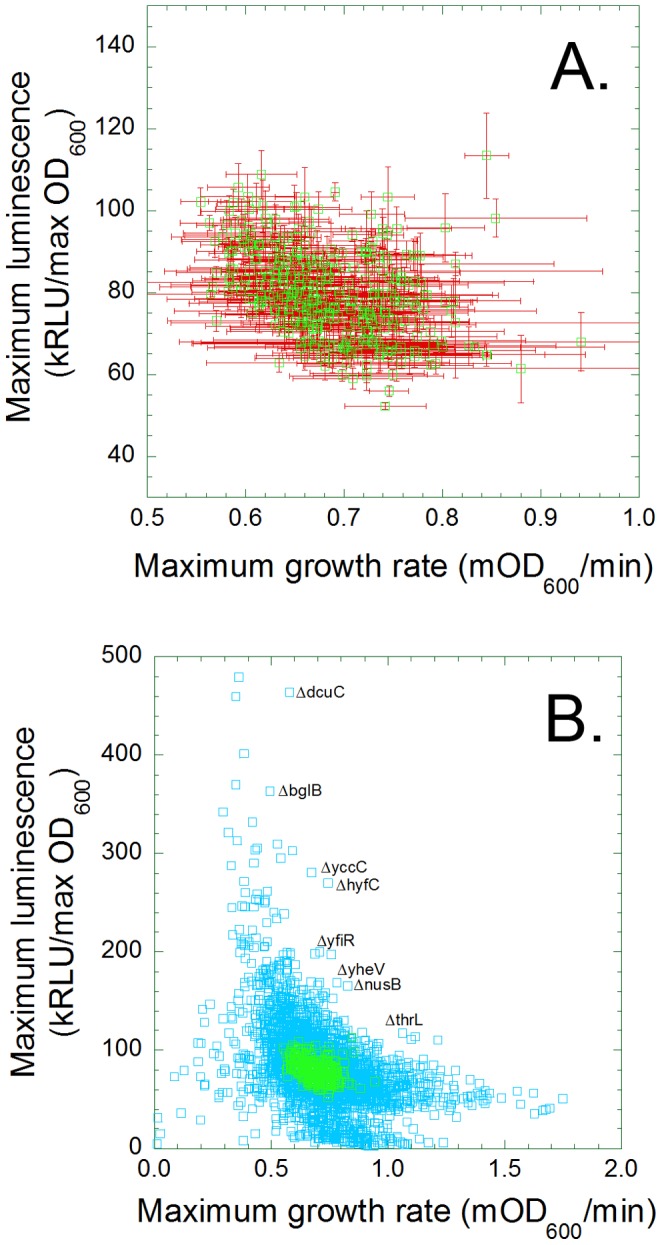
The maximum growth rate and luminescence per cell of 384 lux/BW25113 control replicates (A) or lux/Keio transformants (B) are shown in scatter plots.The distances between points (green squares, A) reflect the variations among isogenic lux/BW25113 cultures in a 384 well plate; the error bars represent the variations between repetitions of the experiment (N = 3). The same data (green squares, B) was plotted among those of the lux/Keio transformant (blue squares, B) to facilitate direct comparisons.